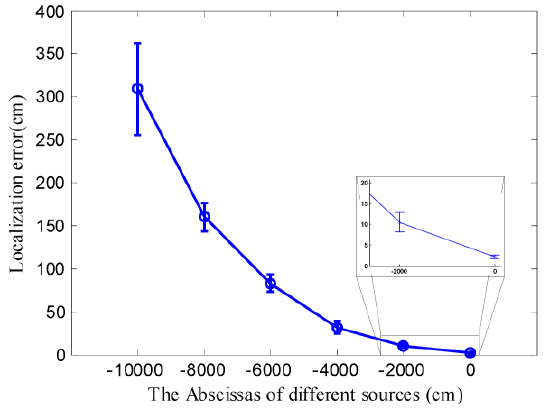
Figure 9. The statistical performance of locating a remote chemical source using